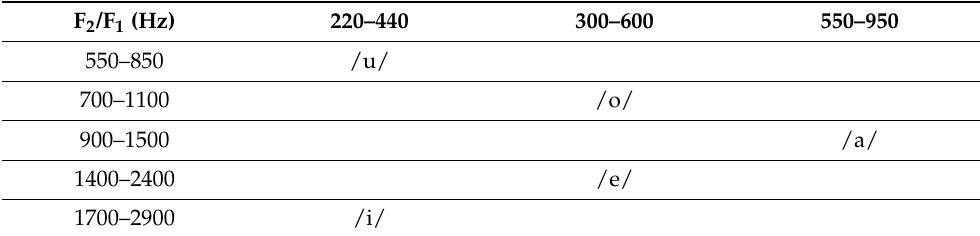
Table 1. Phonological association of formants for the conventional Spanish language